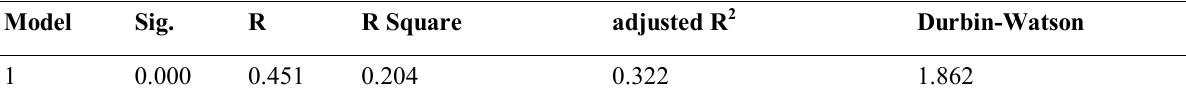
Table 5 – Testing results for the first hypothesis (ANOVA)